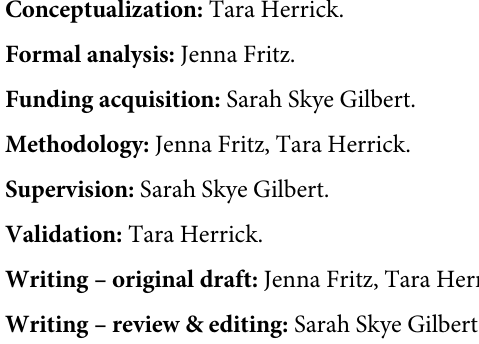
S1 Fig. Literature review and secondary data selection process. Abbreviations: LMIS, logis- tics management information